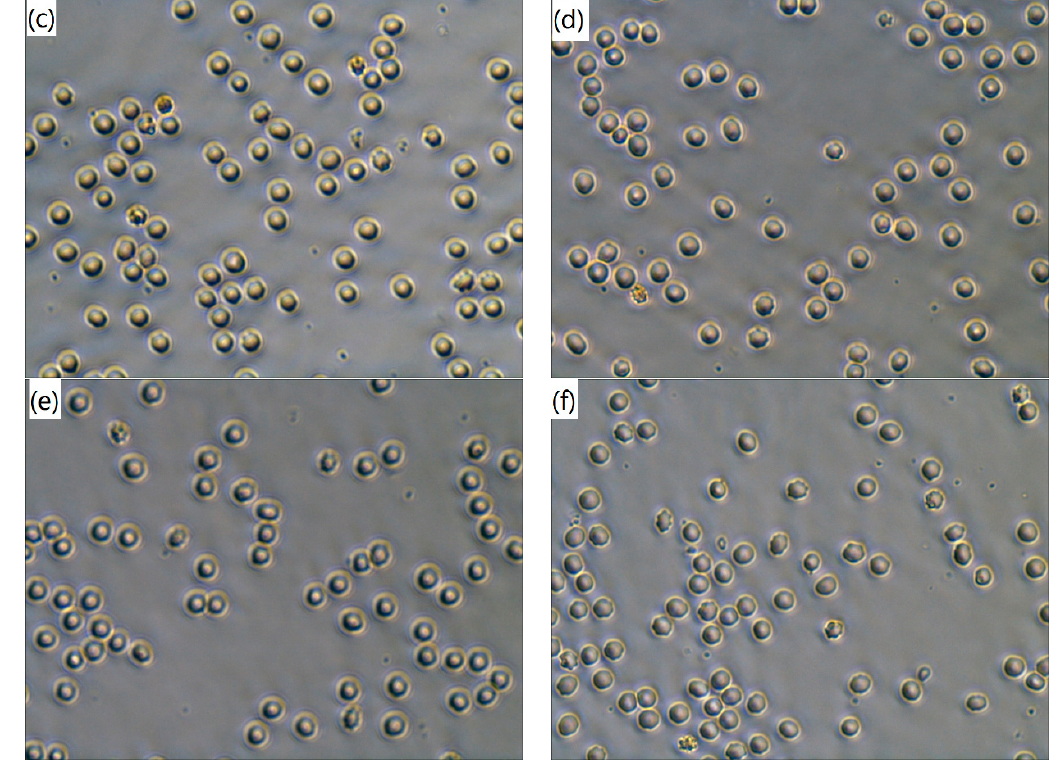
Figure 3. Optical micrographs of human blood red cells in whole blood after 20 min incubation with different specimens: ( a ) blank control; ( b ) S1; ( c ) S2; ( d ) S3; ( e ) S4 and ( f ) S5. All images are at 400× magnification.